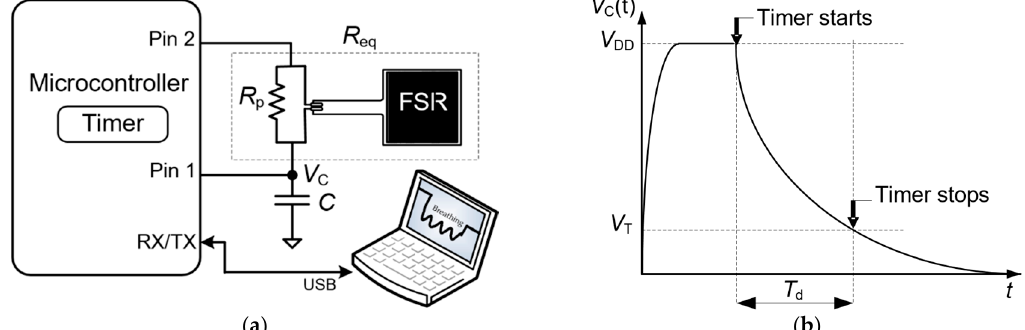
Figure 2. ( a ) DIC applied to measure the FSR; ( b ) waveform of the voltage across C